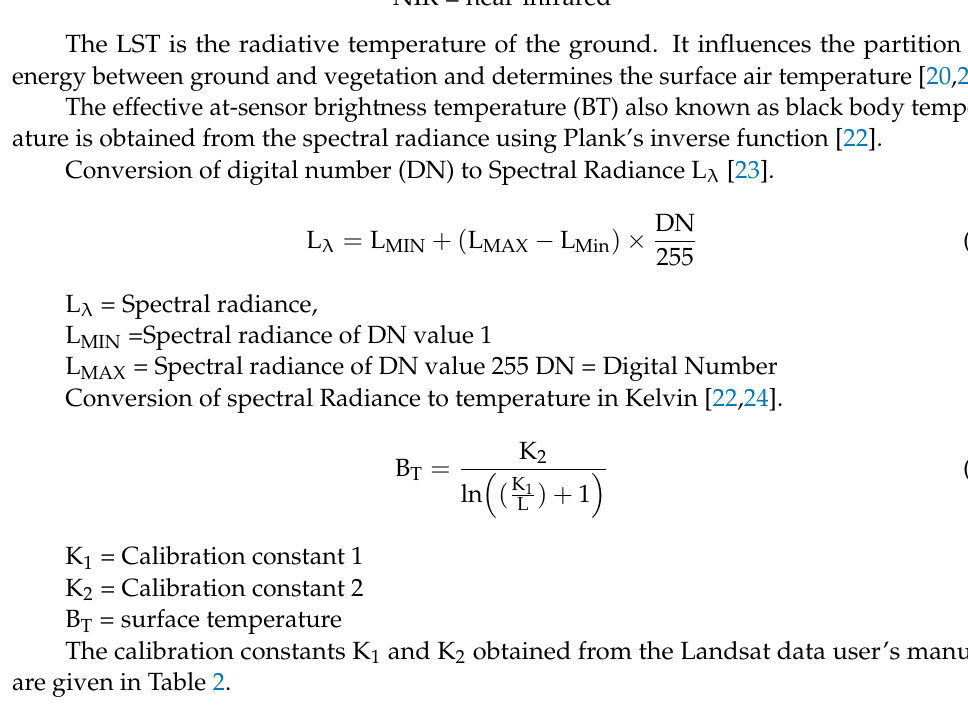
Table 2. TM5 and Landsat 8 thermal band calibration constants.